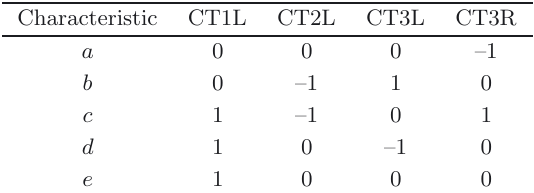
Table 2. Matrix A .